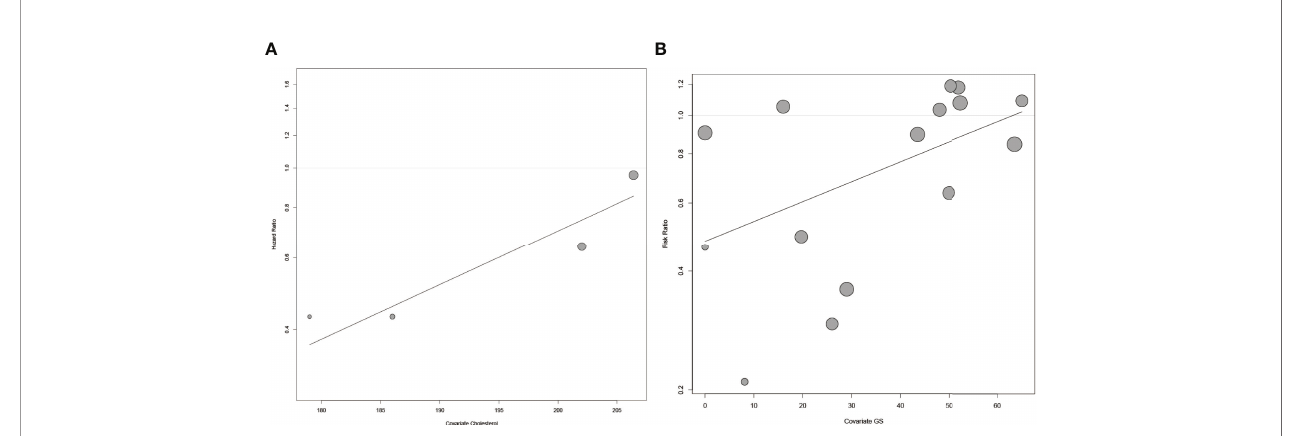
FIGURE 4 | The meta-regression for risk of BCR and covariates. (A) The meta-regression for HR of BCR and the level of serum cholesterol. (B) The meta-regression for RR of BCR and GS. Each dot represents an individual study. Symbol size represents sample